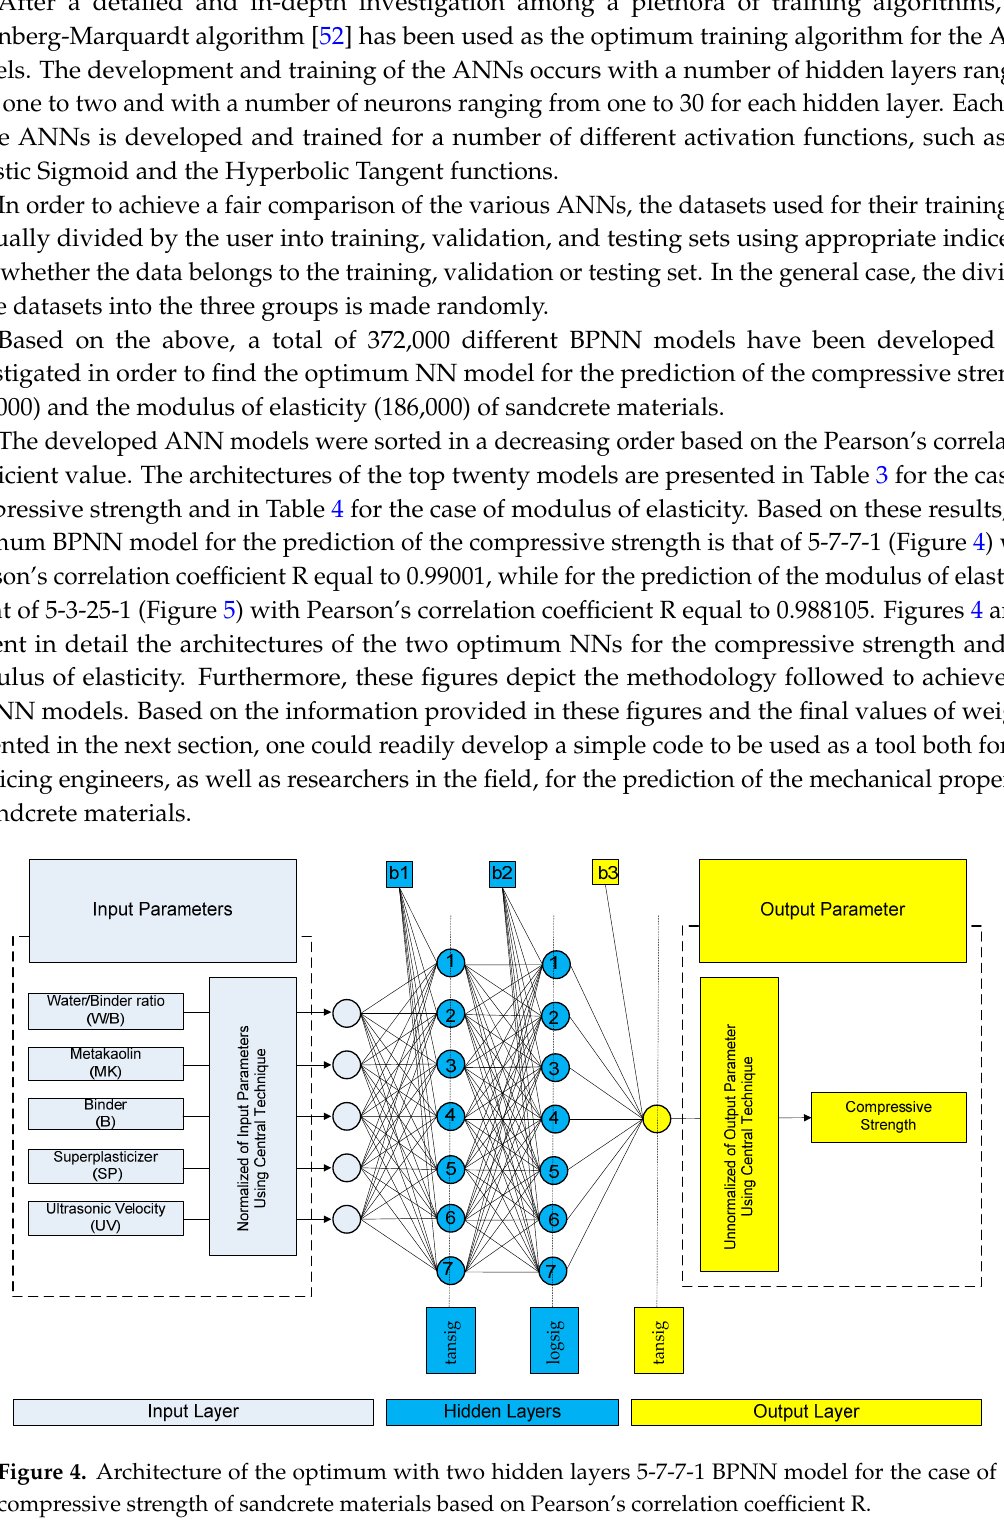
Figure 5. Architecture of the optimum with two hidden layers 5-3-25-1 BPNN model for the case of modulus of elasticity of sandcrete materials based on Pearson’s correlation coefficient R.